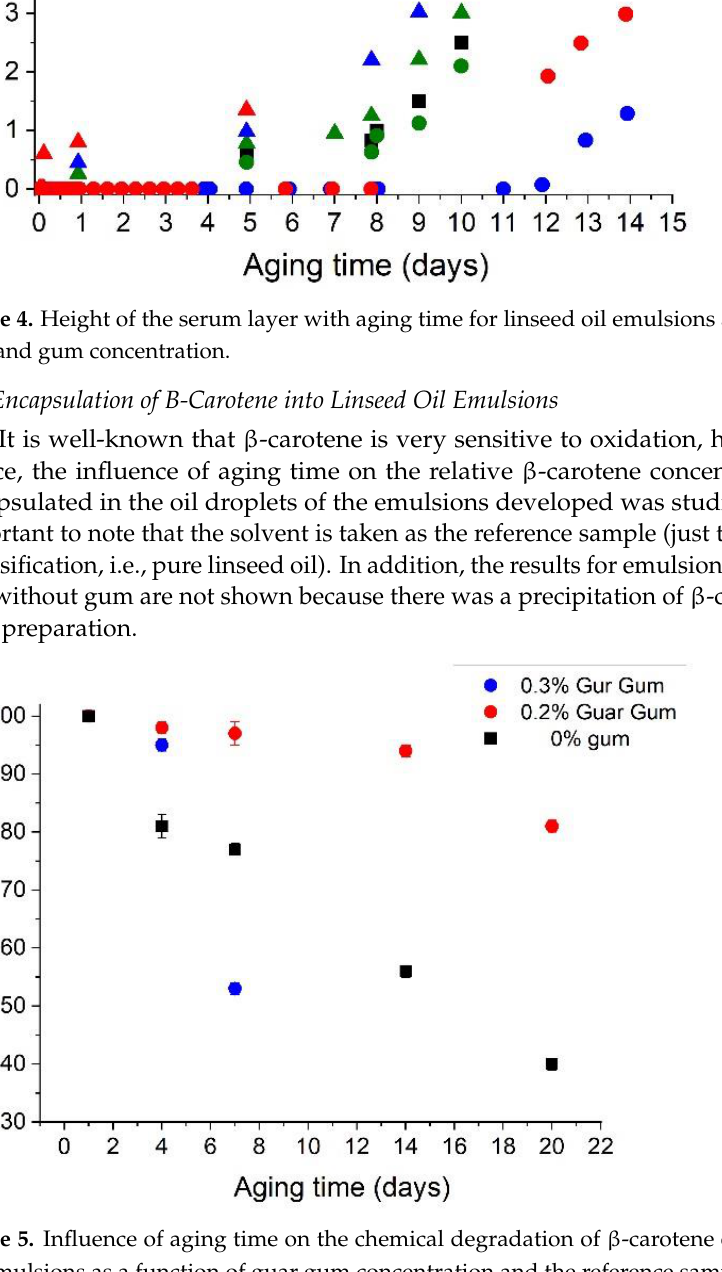
Figure 4. Height of the serum layer with aging time for linseed oil emulsions as a function of gum type and gum concentration.